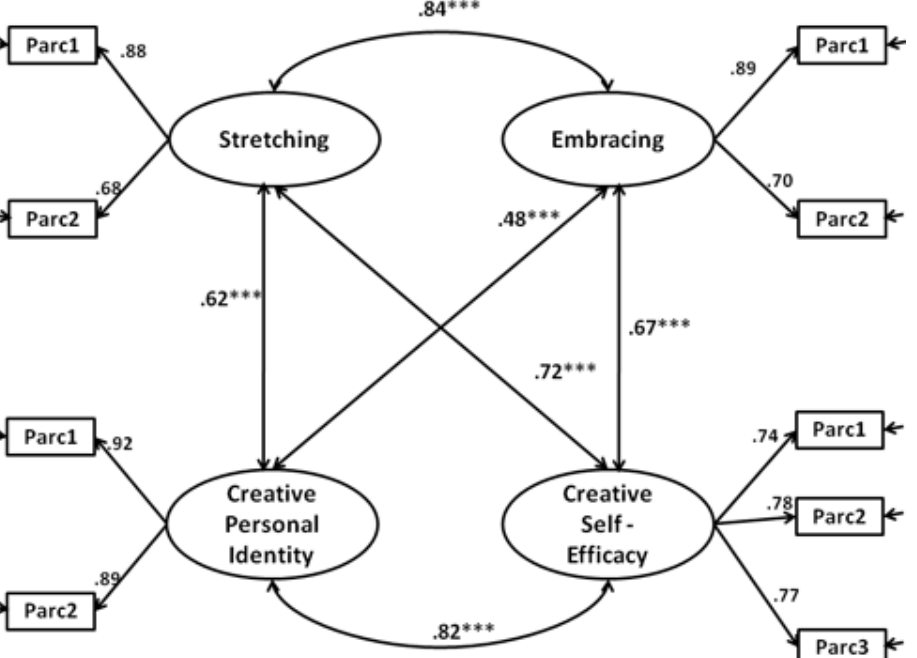
Figure 2. The relationship between stretching, embracing, creative self-efficacy and creative personal identity – model with parcels